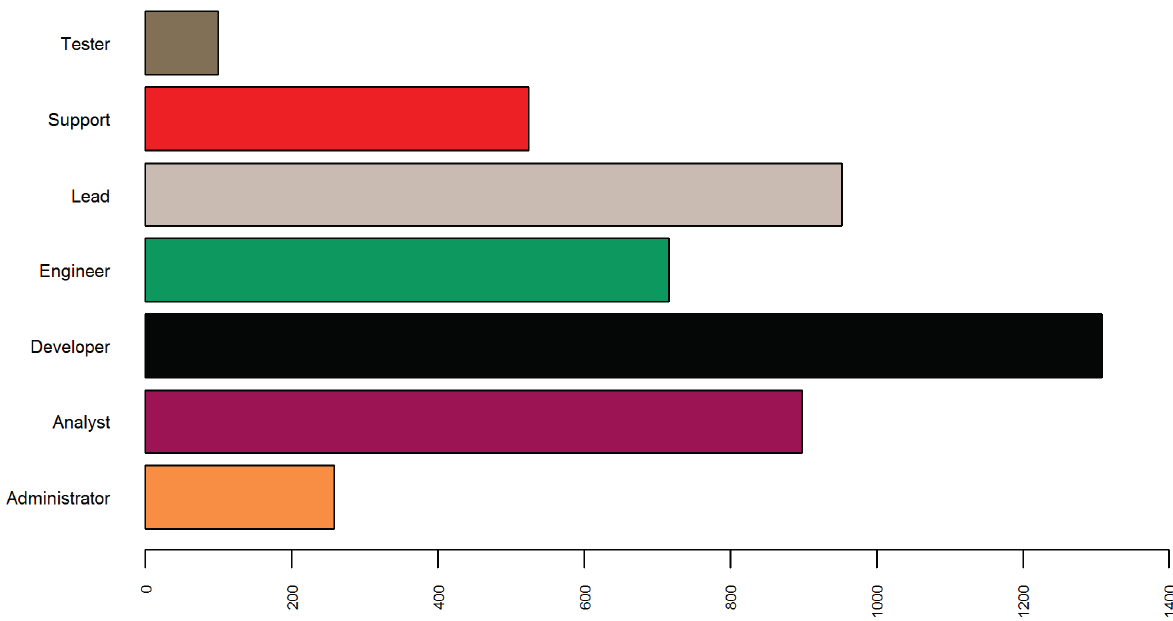
Figure 7. Labelled IT Dataset: Administrator (258), Analyst (898), Developer (1308), Engineer (716), Lead (952), Support (524), Tester